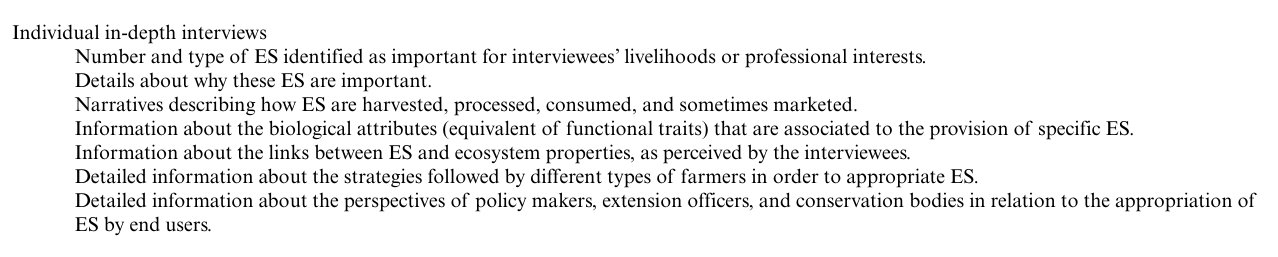
Individual in-depth interviews Number and type of ES identified as important for interviewees’ livelihoods or professional interests. Details about why these ES are important. Narratives describing how ES are harvested, processed, consumed, and sometimes marketed. Information about the biological attributes (equivalent of functional traits) that are associated to the provision of specific ES. Information about the links between ES and ecosystem properties, as perceived by the interviewees. Detailed information about the strategies followed by different types of farmers in order to appropriate ES. Detailed information about the perspectives of policy makers, extension officers, and conservation bodies in relation to the appropriation of ES by end